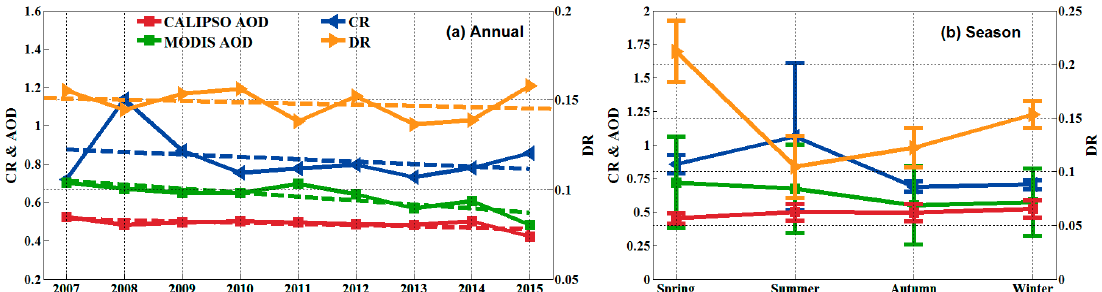
Figure 8. Annual and seasonal distributions of the column aerosol optical depth, color ratio, and depolarization ratio observed by the CALIPSO and MODIS AOD over central China from March 2007 to February 2016. The dashed lines in Figure 8a are the linear trend fitting lines of the annual means for each aerosol parameters.